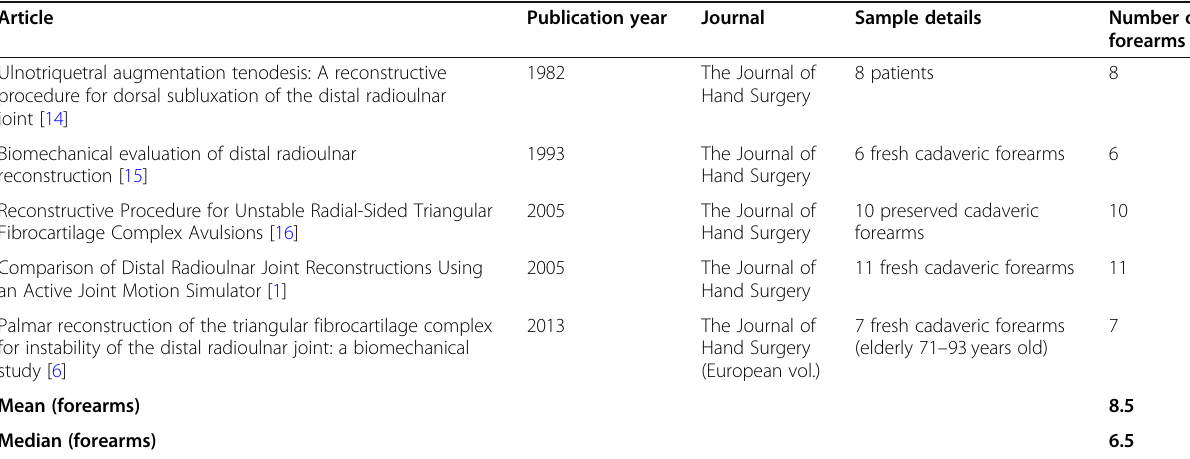
Table 1 Sample calculation according to previous